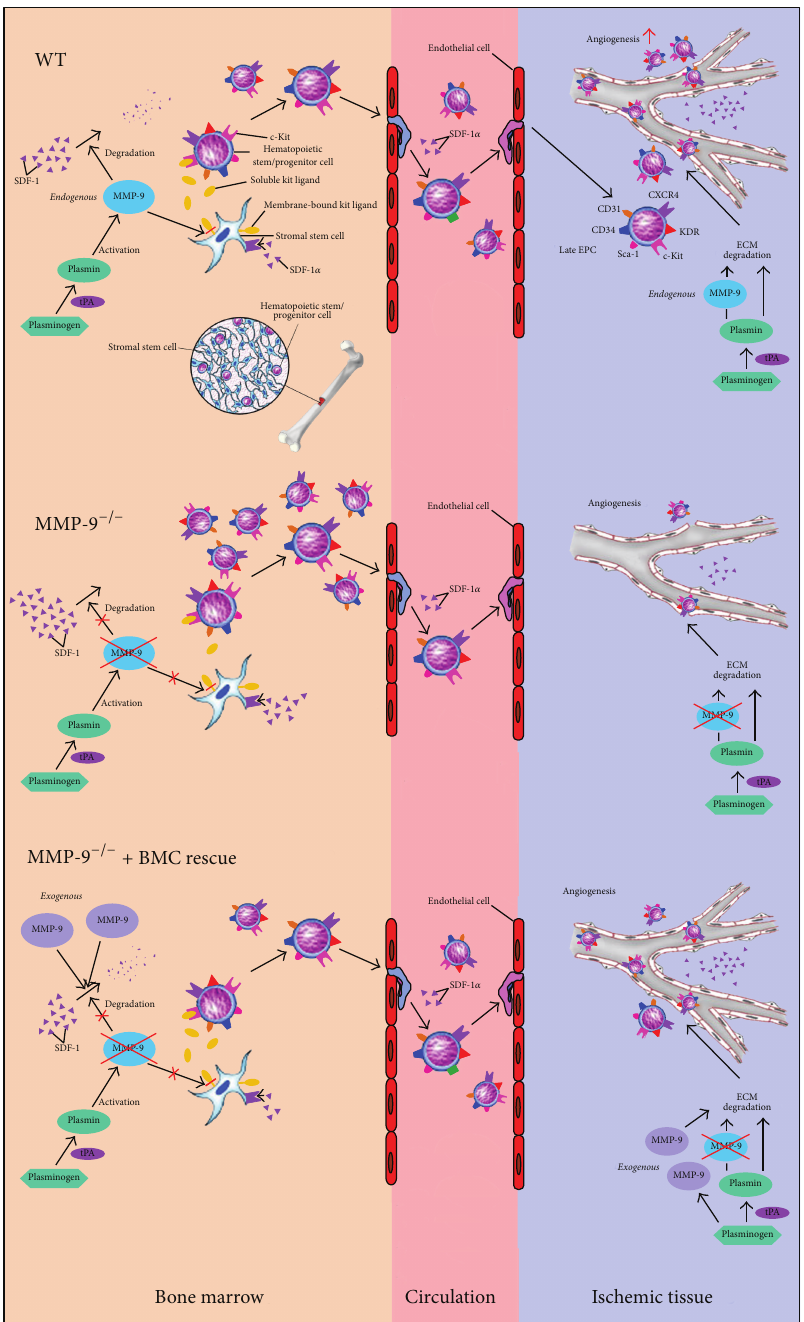
Figure 16: Proposed mechanisms. The proposed rescue model of bone marrow cells (BMC) transplantation on enhancing angiogenesis in matrix metalloproteinase- (MMP-) 9 deficient mice with critical limb ischemia. EPC = endothelial progenitor cells; SDF-1 𝛼 = stromal cell- derived factor-1 𝛼 ; ECM = extracellular